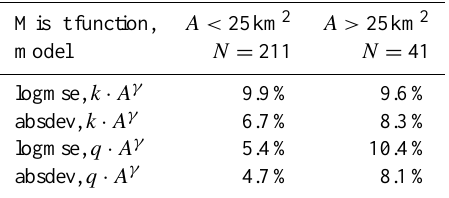
Table 3. Root mean square error in global volumes using different calibration methods when tested on the Huss and Farinotti (2012) areas and volumes. N is the size of the calibration data set, and q = 6V obs /6A γ obs